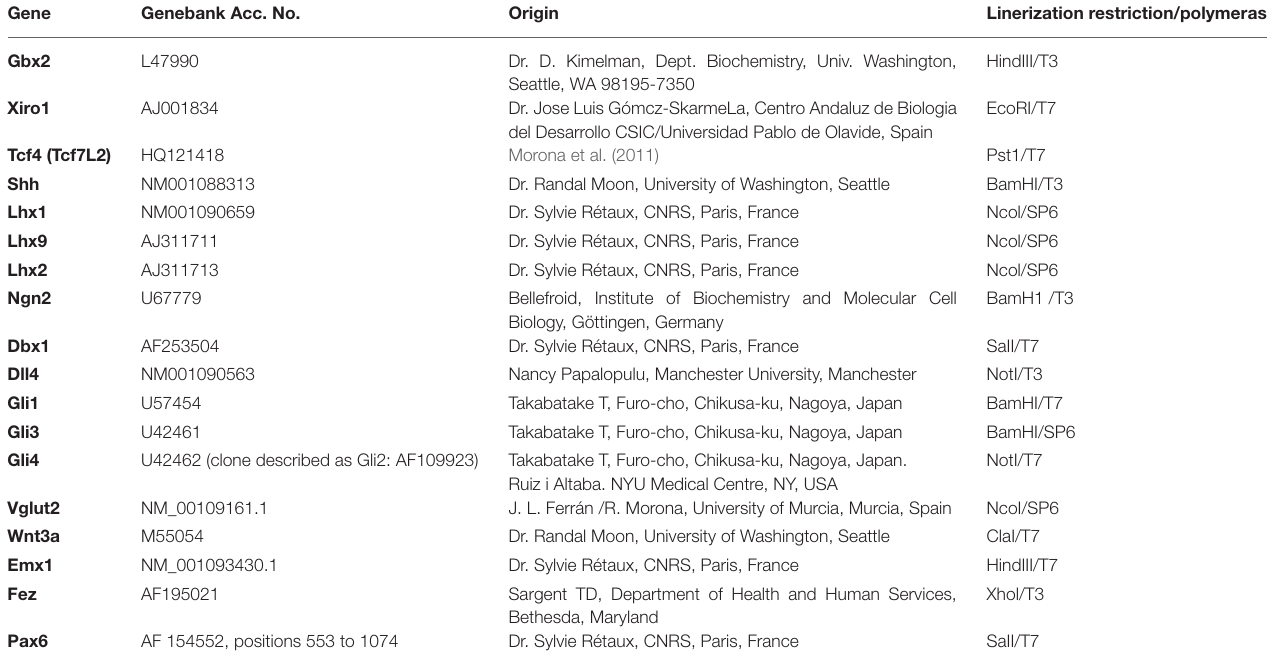
TABLE 2 | List of gene markers used, sequence of the gene in the construct, origin of the plasmid, and enzymes employed to synthesize the probe. Gene Genebank Acc.